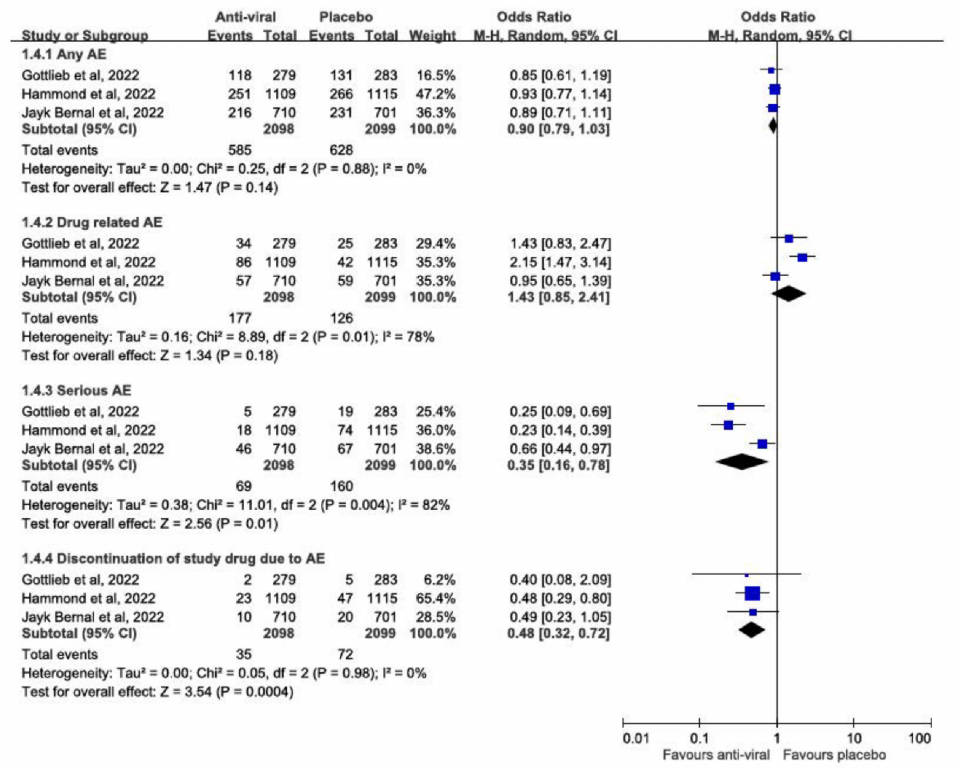
Figure 4. Meta-analysis of the risk of AEs between anti-viral agents and placebo